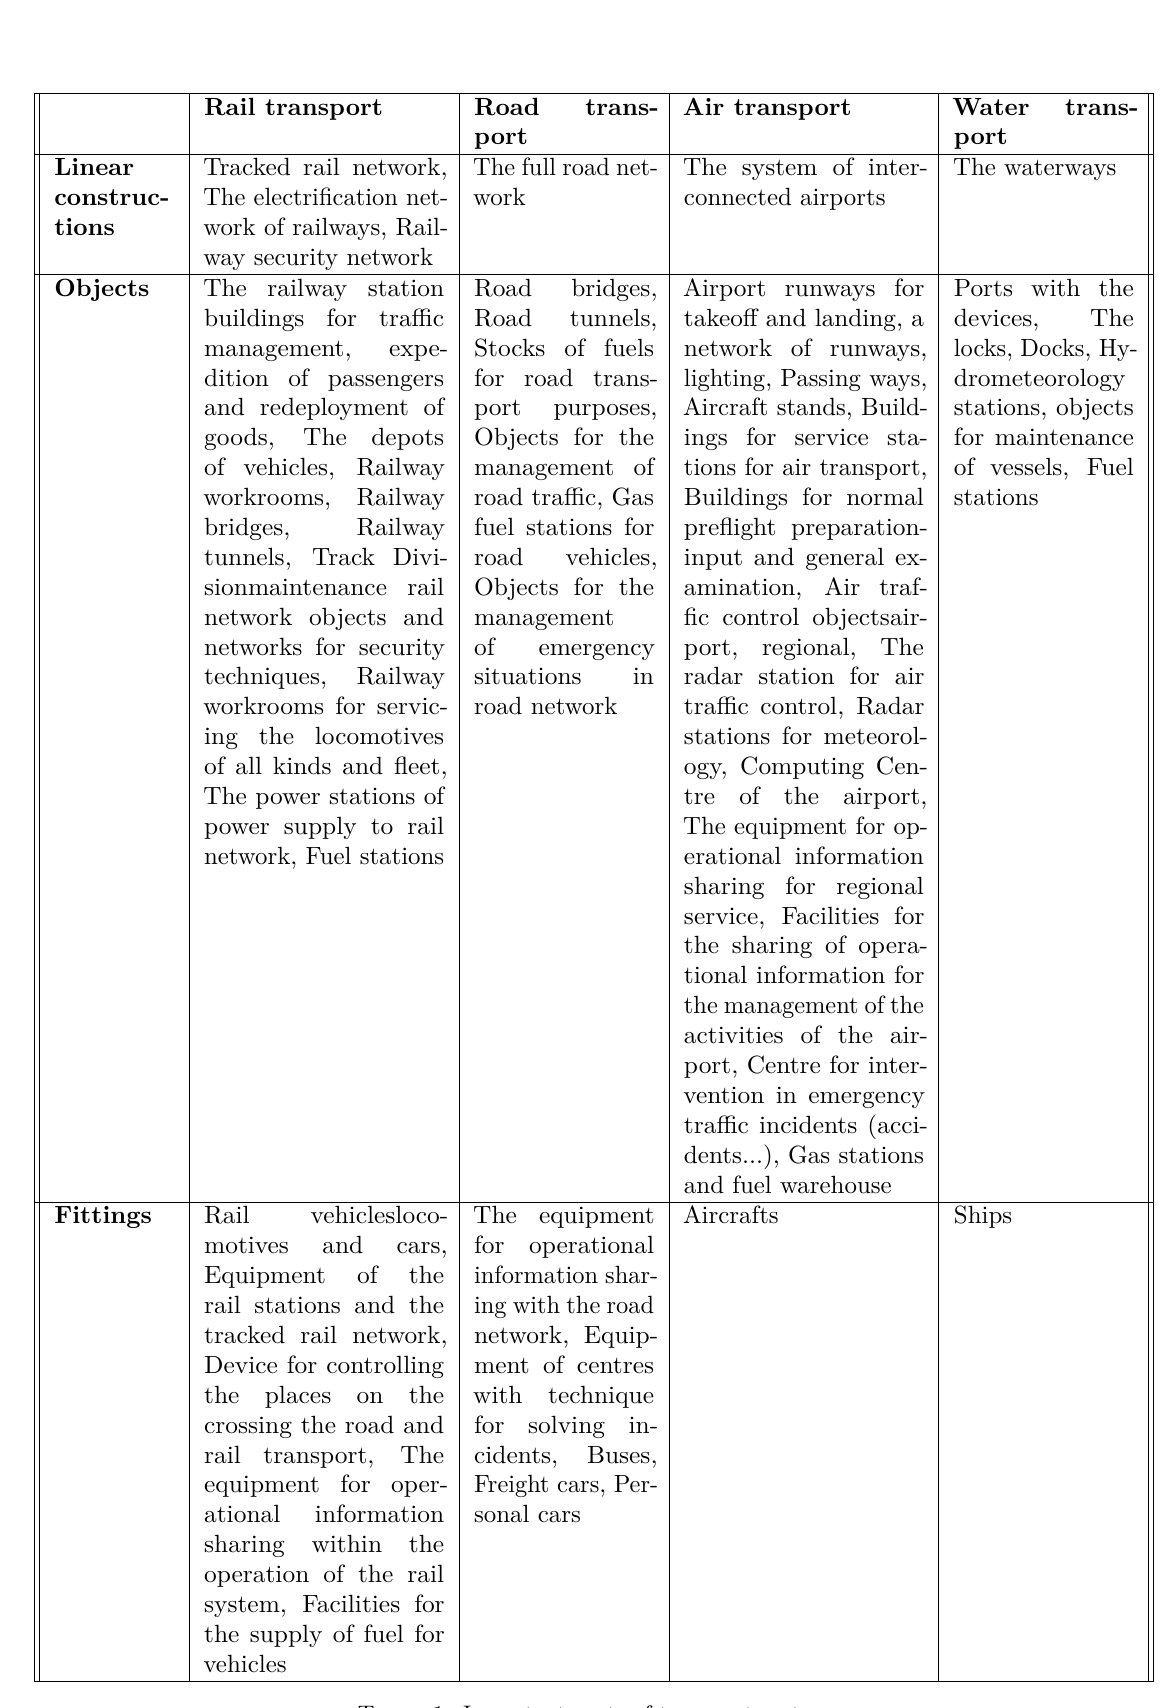
Table 1. Important parts of transport